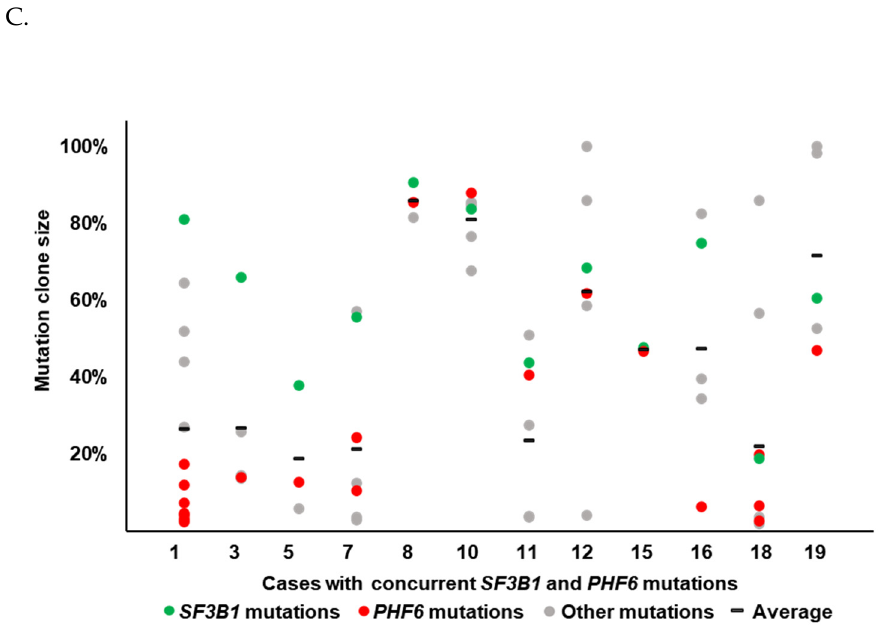
Figure 2. Molecular features of cases of myeloid neoplasms with SF3B1 and PHF6 mutations. ( A ) The location and number of SF3B1 and PHF6 mutations. ( B ) The mutation profile heatmap. The cases were divided into four categories: myelodysplastic syndrome (MDS), acute myeloid leukemia (AML), myeloproliferative neoplasms (MPN), and myelodysplastic/myeloproliferative neoplasms (MDS/MPN). Each column represents a single case. Overall, the most frequent concurrent mutations were TET2 , ASXL1 , DNMT3A , and RUNX1 . ( C ) Mutation clone size of each case. Normalized variant allele frequencies (VAFs) in a representative test of each of the 12 myeloid neoplasms cases with a significant level of concurrent SF3B1 and PHF6 mutations are shown.